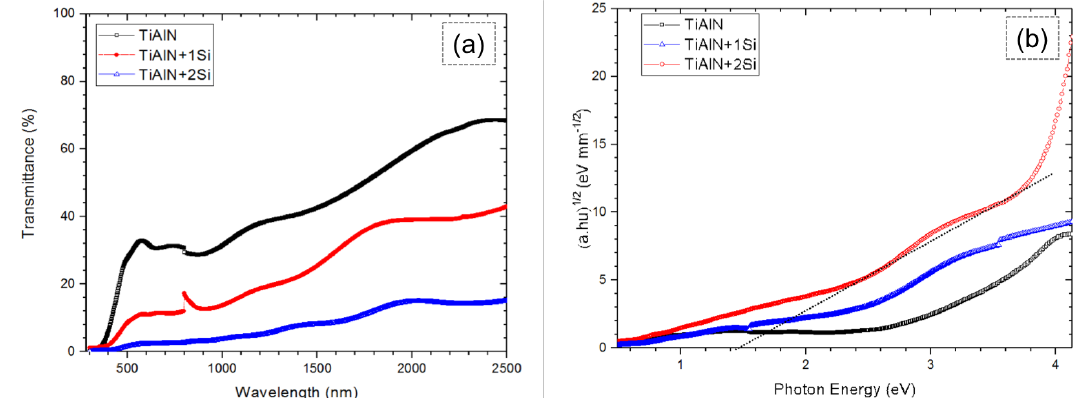
Figure 6. (a) Transmittance as a function of wavelength and (b) (αhν) 1/2 Vs photon energy of the (Al,Ti,Si)N films deposited on common glass, taking as study parameter the Si